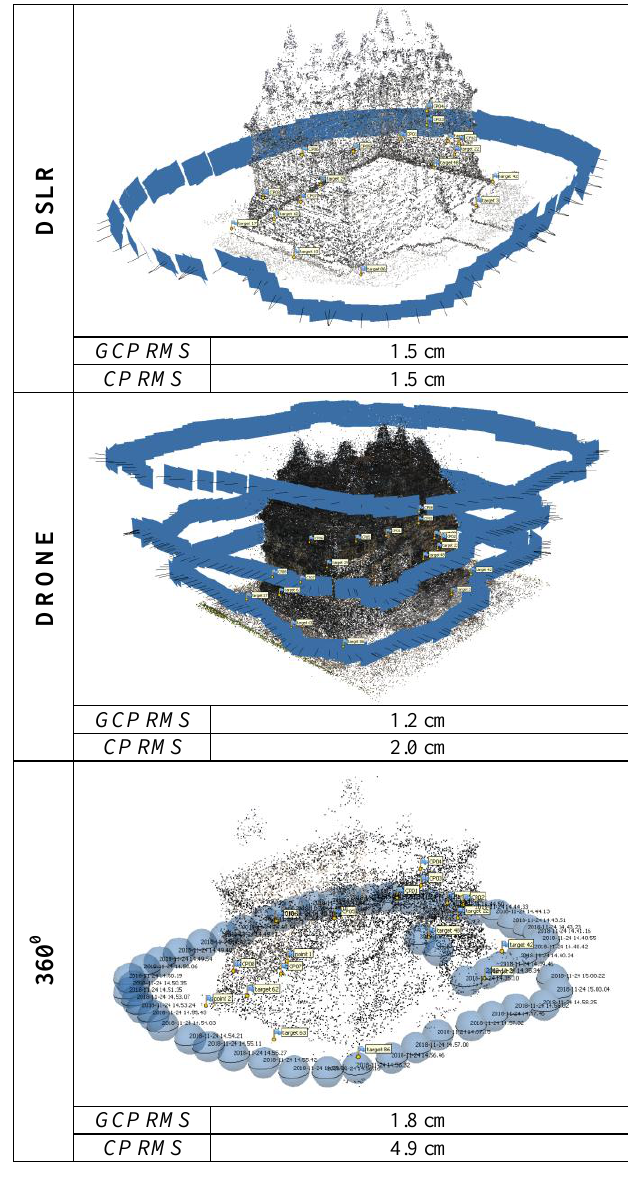
Figure 1. Summary of the bundle adjustment quality as well as illustration of the image and control points network for the three tested data